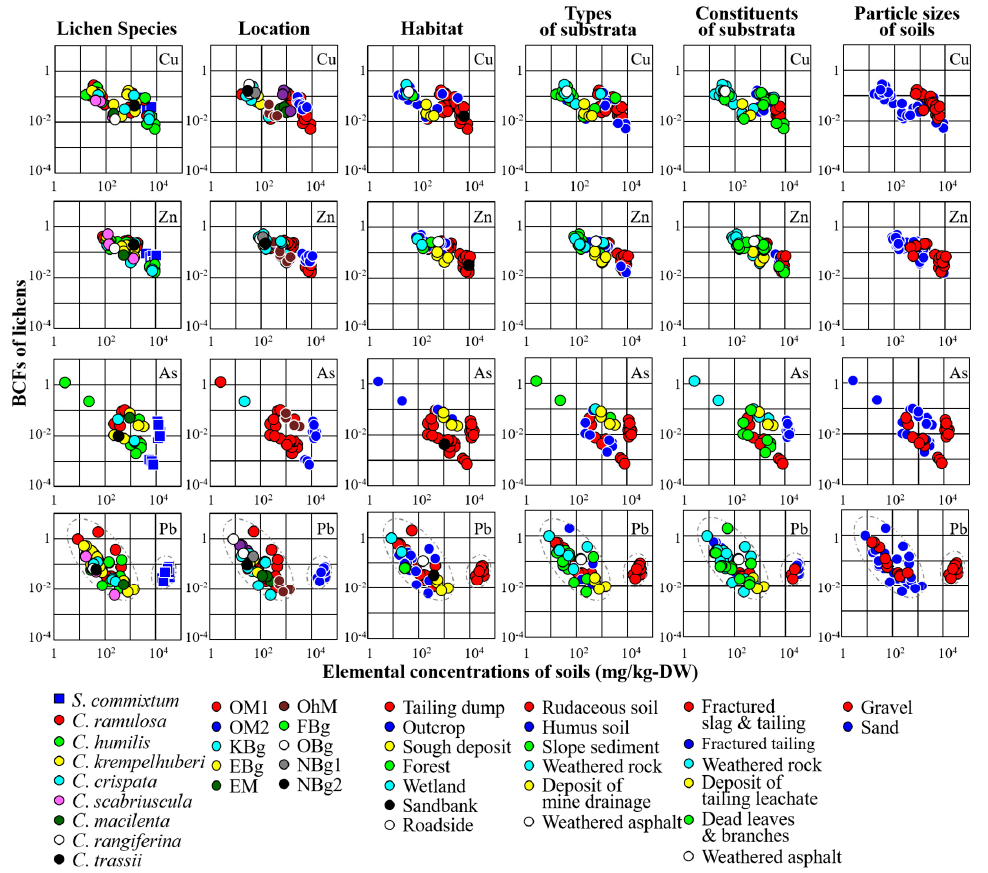
Figure 7. Scatterplots showing relationships between the BCFs and the elemental concentrations in soils, separated by lichen species, location, habitat, types of substrata, constituents of substrata, and particle sizes of soils using different